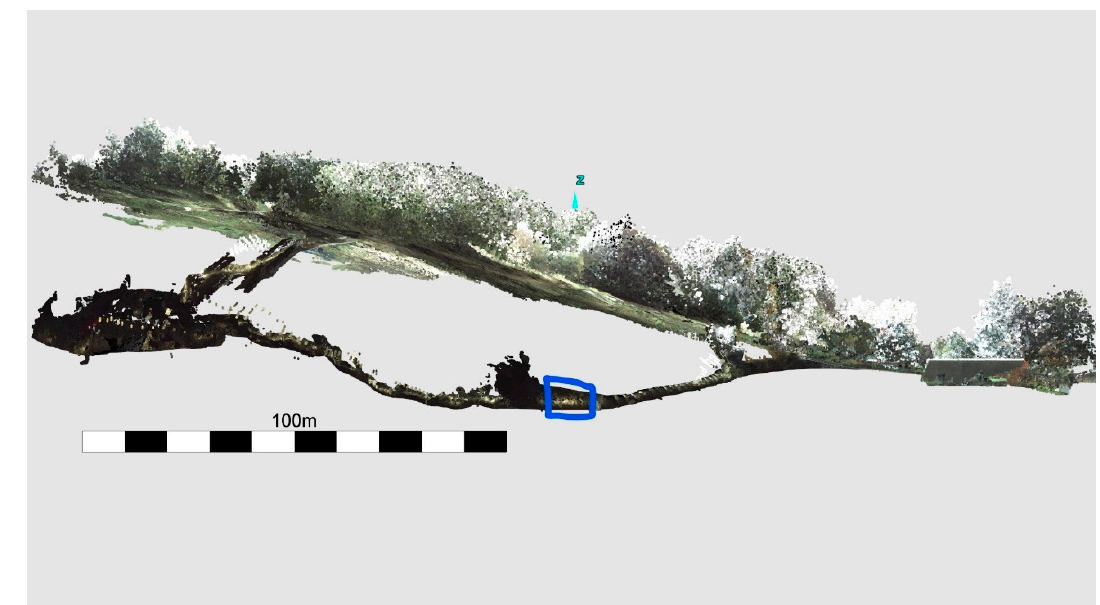
Figure 1. Elevation view of the Masson Cavern at the Heights of Abraham, Derbyshire. Blue polygon refers to close-up view in Figure 2.